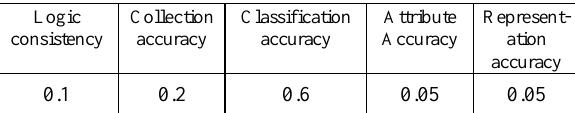
Figure 1 Schematic of Fuzzy-AHP model